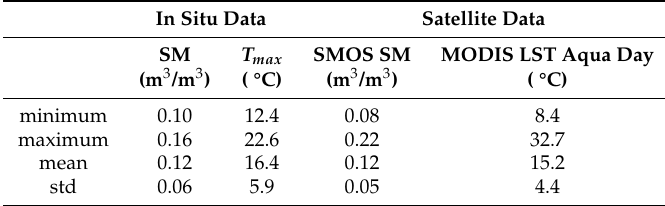
Table 1. Statistics obtained from SM–LST coupling/decoupling transitions along the study